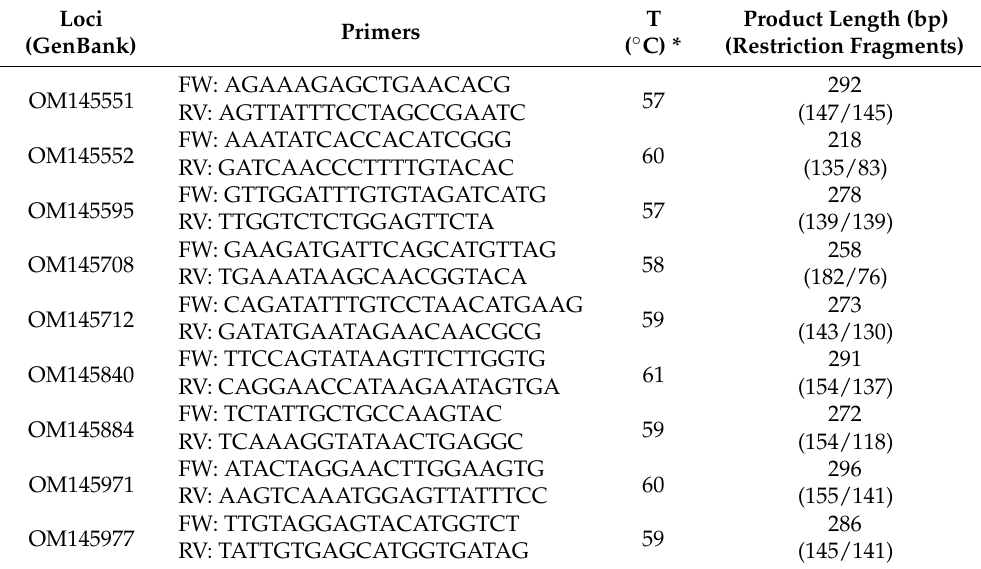
Table 3. Analyzed SNP-CAPS markers.